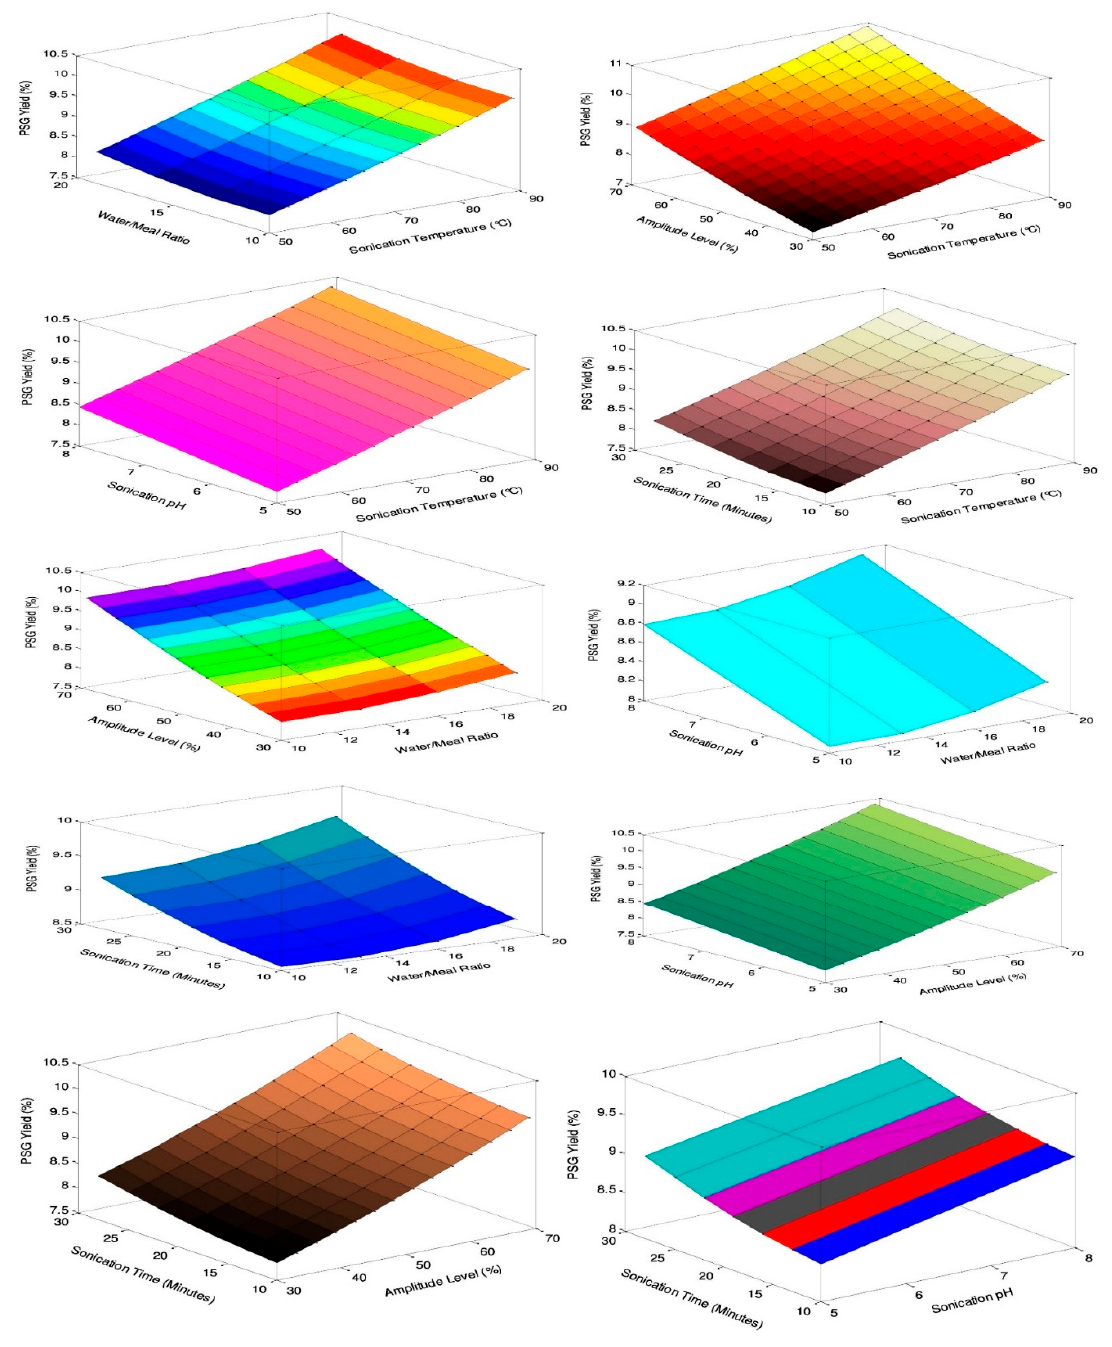
Figure 2. Effects of mutual interactions on PSG yield.